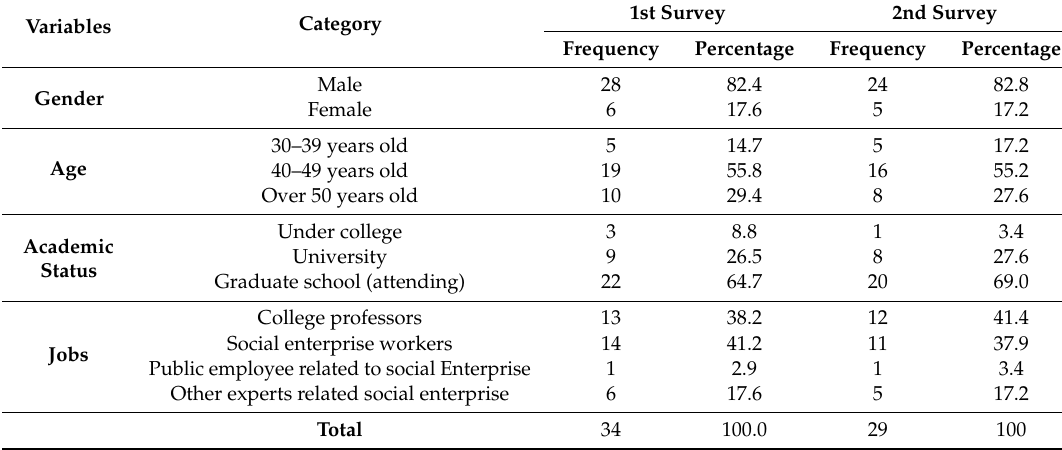
Table 1. Characteristics of the Subjects.